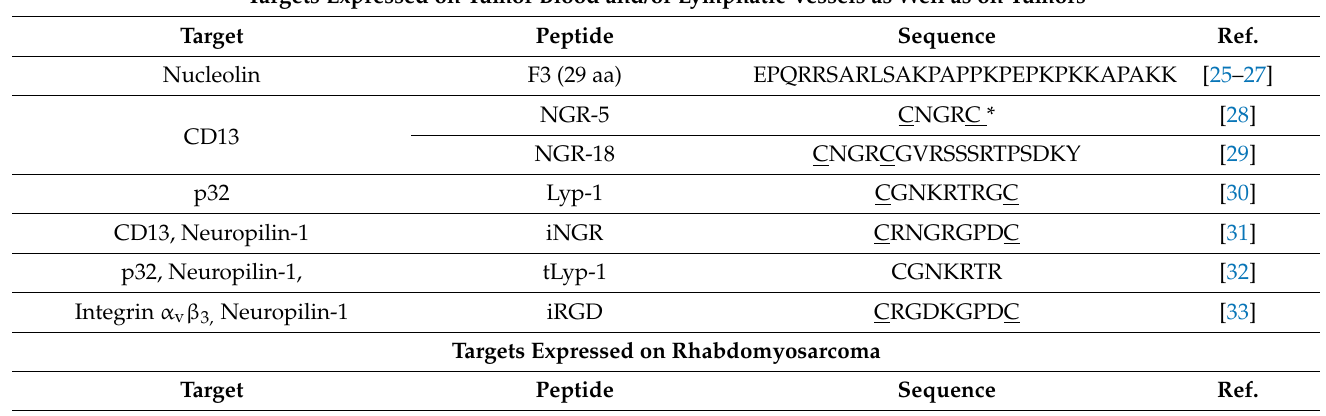
Table 1. Rhabdomyosarcoma cell surface proteins as potential peptide-ligands targets. Targets Expressed on Tumor Blood and/or Lymphatic Vessels as Well as on